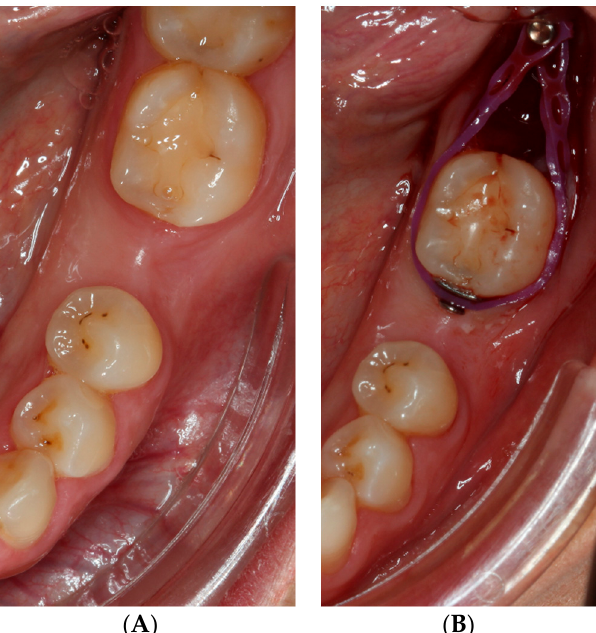
Figure 1. ( A ) Initial case with lack of available mesiodistal space for the replacement of the missing tooth. ( B ) Case after extraction of third molar and insertion of the miniscrew attached with an elastic chain to a mesial button of the tooth to upright.